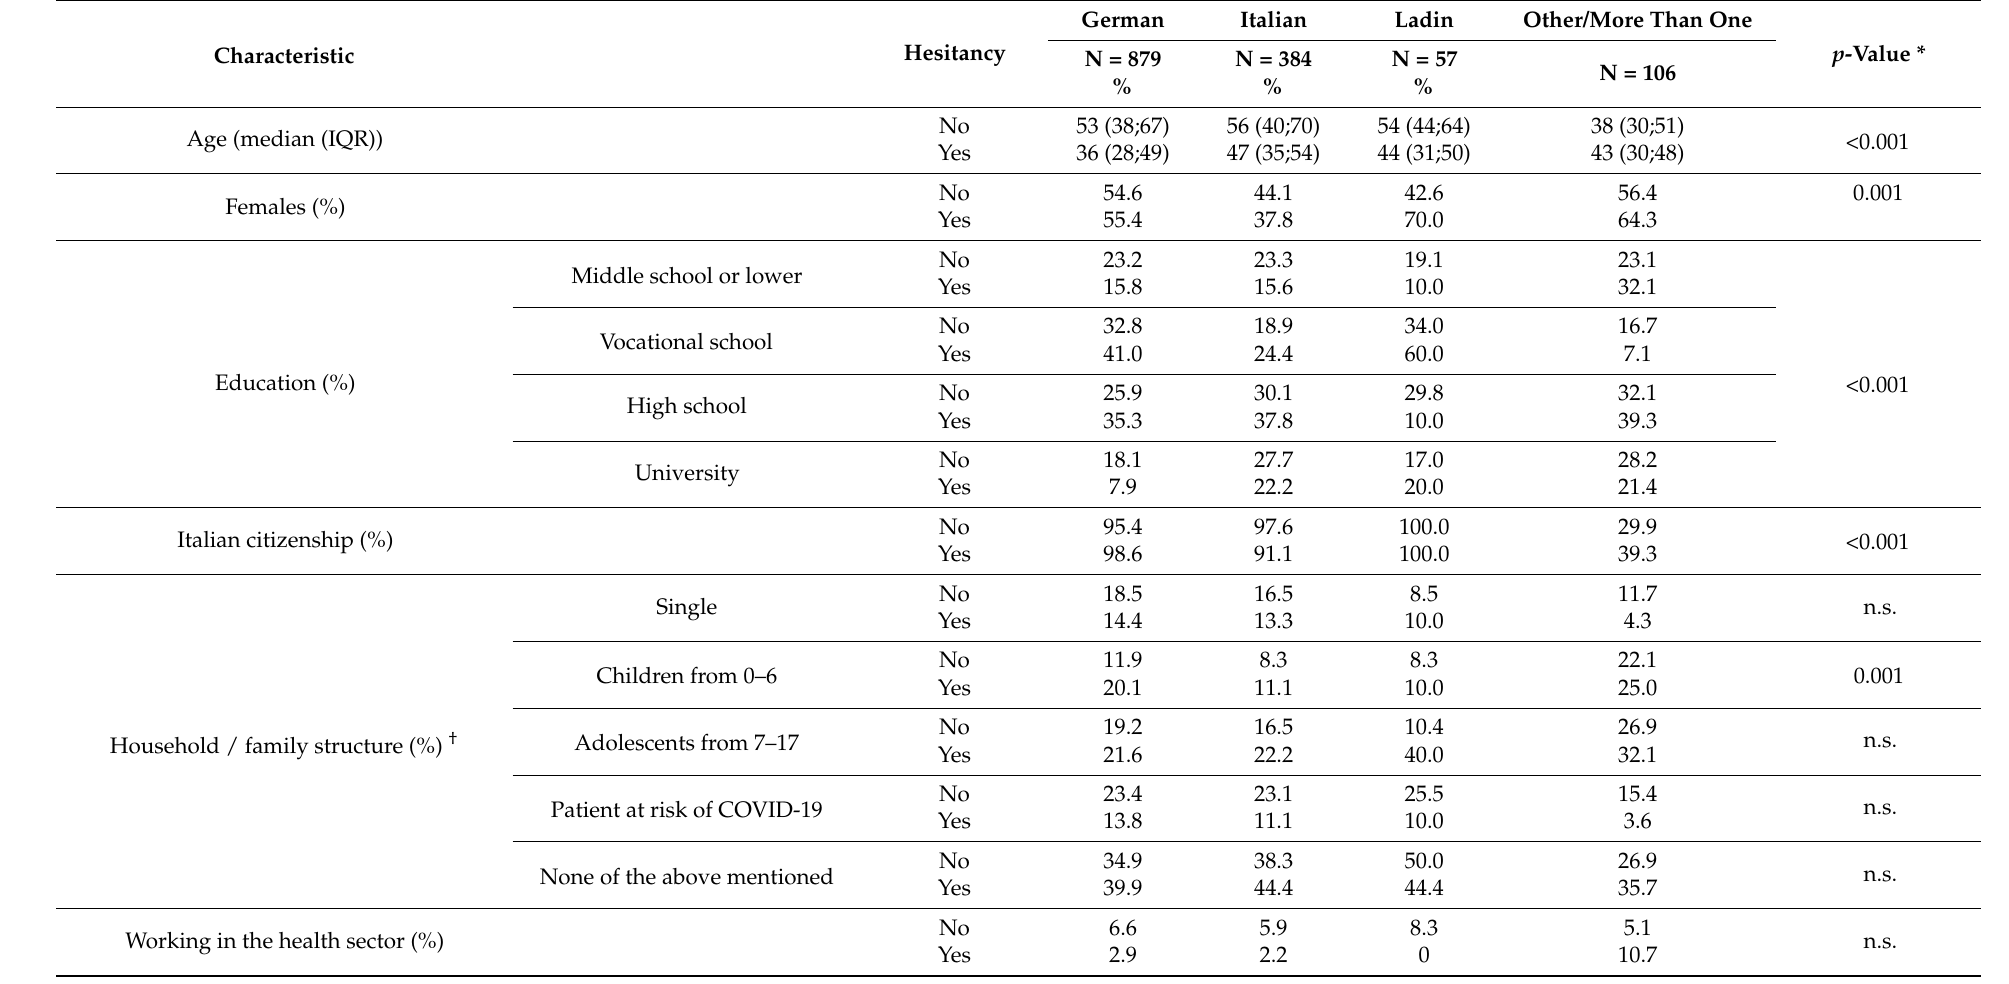
Table 4. Language-specific baseline characteristics and vaccine hesitancy of study